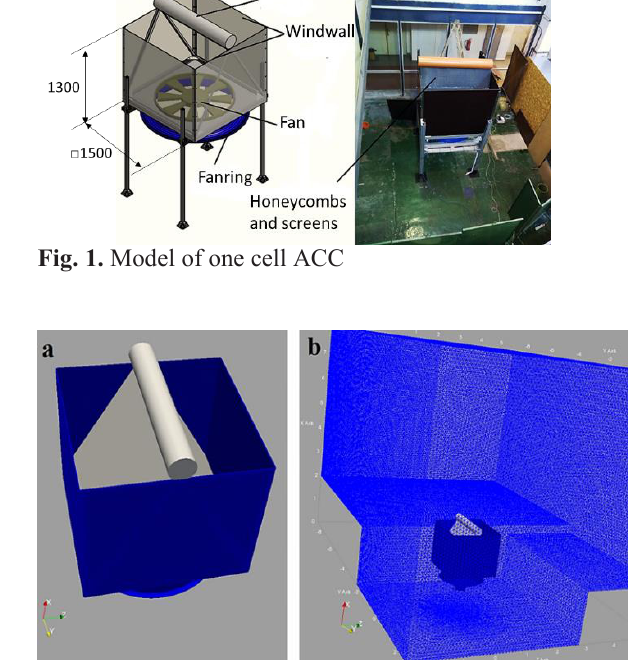
Fig. 2. Computational domain of CFD